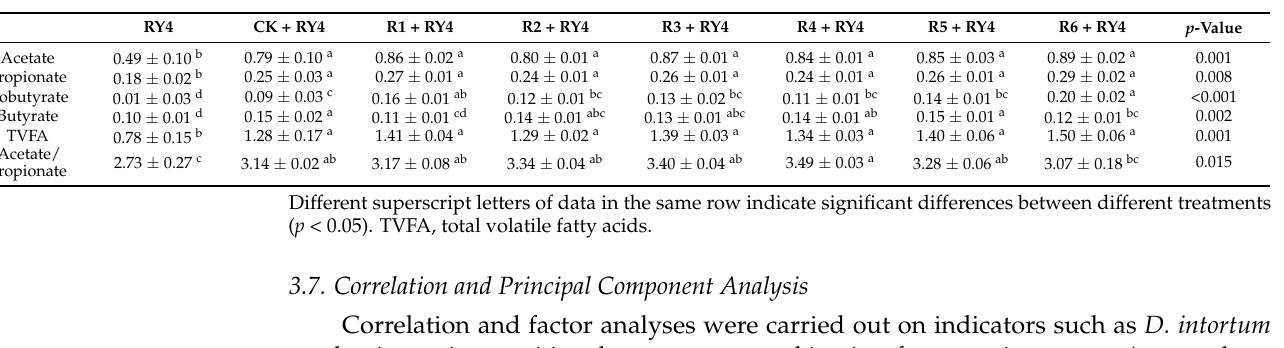
Table 7. Volatile fatty acid content of in vitro fermentation